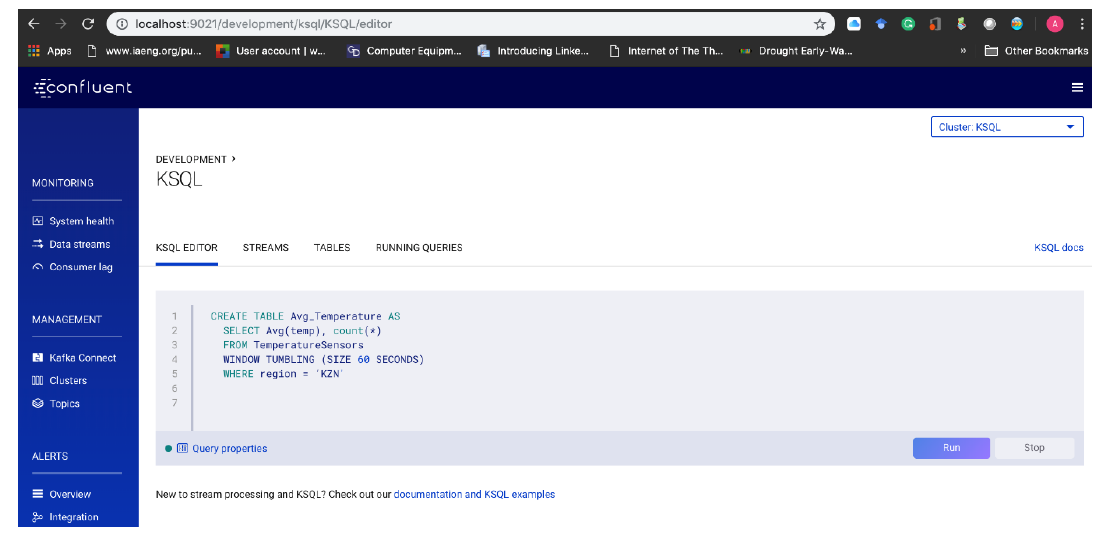
Figure 16. KSQL editor in the Confluent Platform. Algorithm 1: KSQL Querying